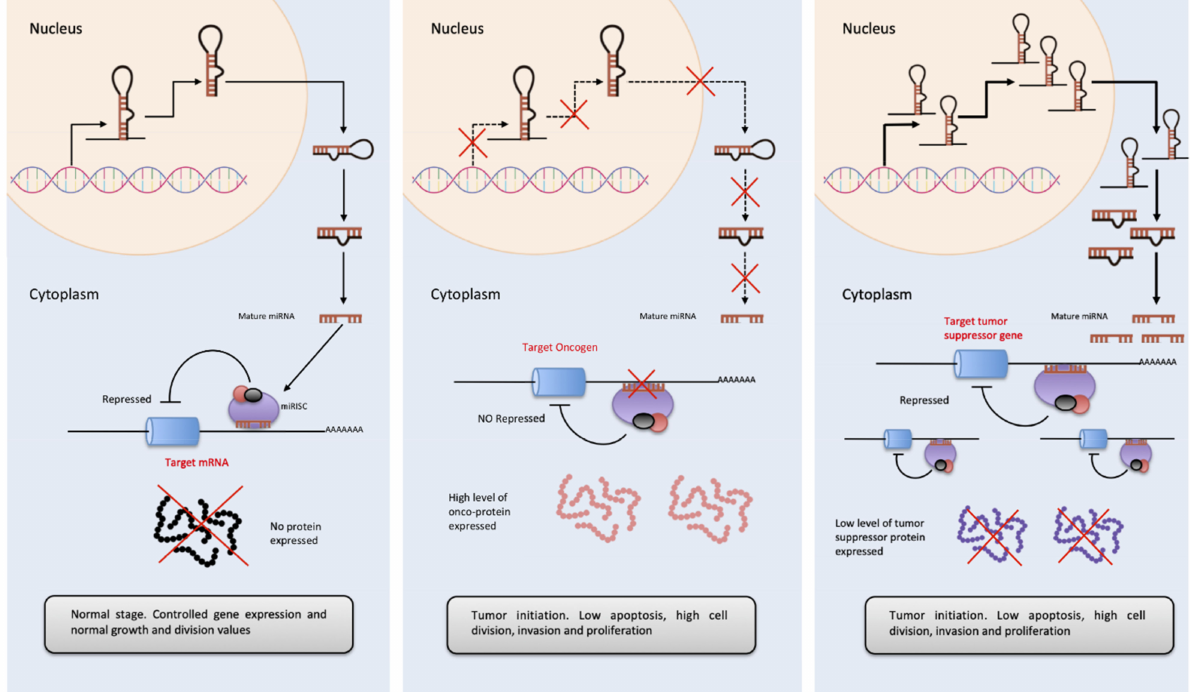
Figure 3. OncomiRs involvement in tumor initiation process. Left . The diagram represents basal expression of miRNAs. These are released to the cytoplasm in a highly controlled amount, to exert their function by binding to the 3 (cid:48) -UTR of their target mRNA, inhibiting the formation of protein. Center . In the case of cancer, the expression of multiple genes is altered, if this variation causes an inhibition of OncomiRs (miRNAs that regulate oncogene expressions), these are not able to inhibit the amount of oncogenic protein, favoring proliferation, cell cycle progression as well as a decrease in apoptosis and in the tumor initiation. Right . On the contrary, in cancer, the overexpression of miRNAs acting as tumor suppressor regulators has also been observed (essentially, they are miRNAs that inhibit the expression of tumor suppressor genes). A considerable increase in the cytoplasm of OncomiRs, causes the almost disappearance of tumor suppressor proteins, favoring the development of cancer, its progression and tumor